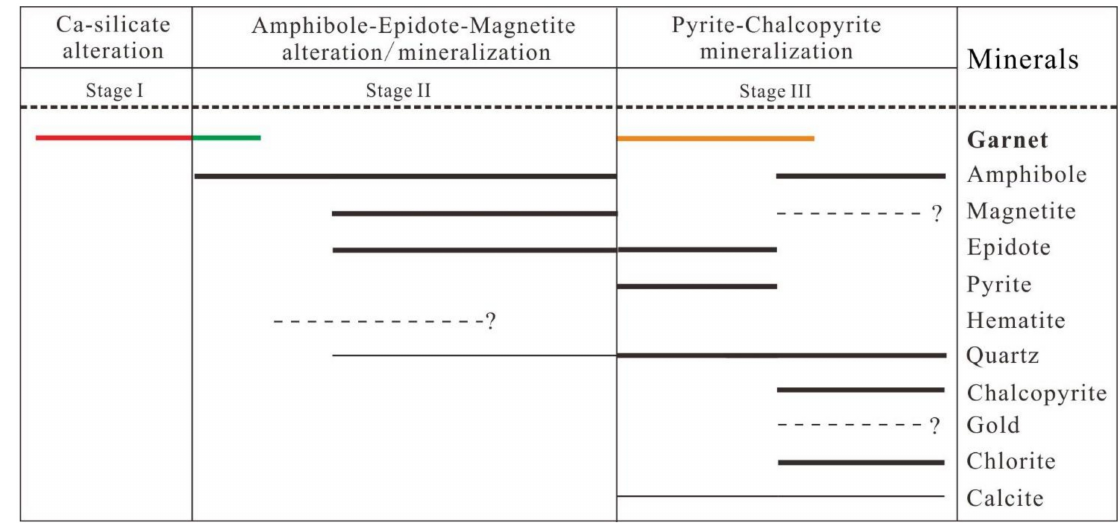
Figure 4. Representative alteration and mineralization paragenesis of the Laoshankou deposit (modified from [26]). 3. Samples and Analytical Methods